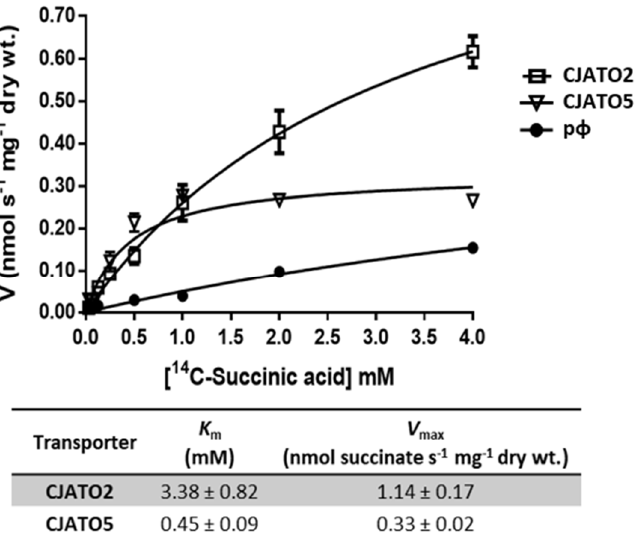
Figure 4. Initial uptake rates of radiolabeled 14 C − succinic acid, pH 5.0, as a function of the acid concentration in S. cerevisiae IMX1000 cells expressing the pCjAto2 (empty squares) and pCjAto5 (empty triangles). As a negative control, cells transformed with the p416GPD were used (full circles). The kinetic parameters presented in the table were estimated using the computer-assisted non-linear regression analysis of the plots.